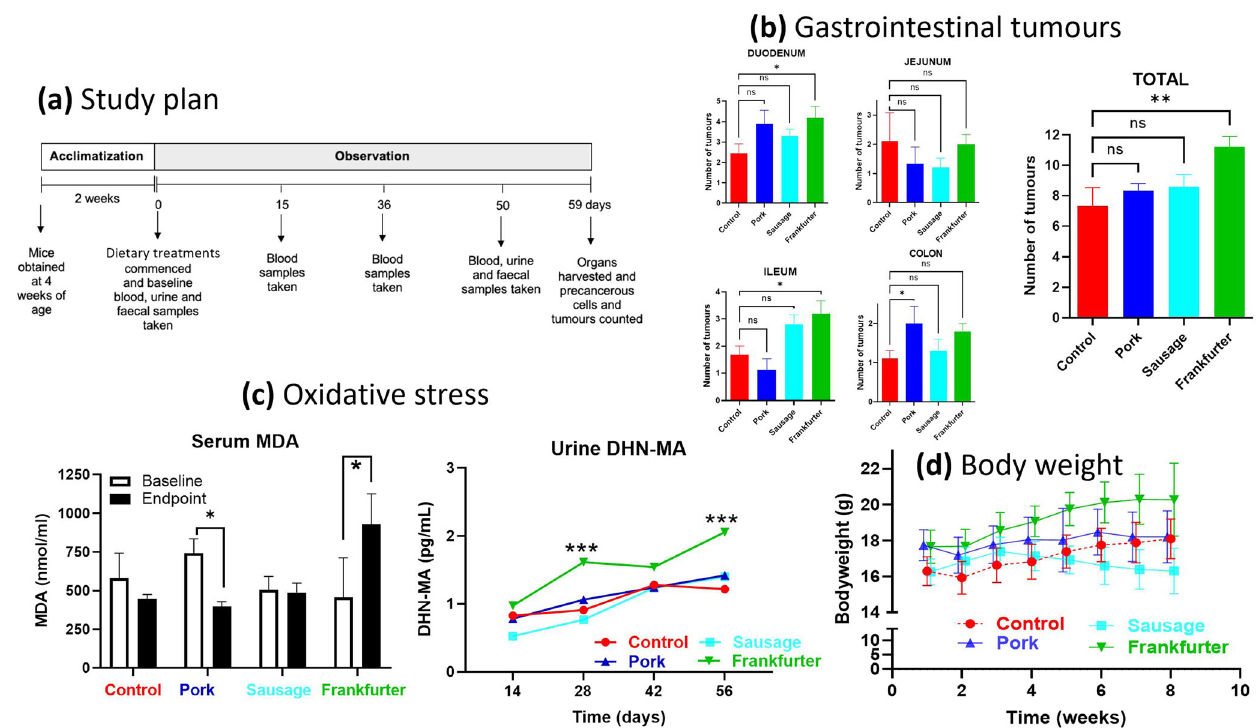
Fig. 1 APC Min mice consuming 15% frankfurter (85% chow) for 8 weeks have signi fi cantly more gastrointestinal tumours, higher levels of lipid peroxidation, and greater bodyweight than APC Min mice consuming a control diet (100% chow). a after acclimatisation mice were fed one of four chow diets which were either Control ( n = 9; standard chow (red)), or chow with a 15% incorporation of pork mince ( n = 9; blue), pork sausage ( n = 10; light blue), or nitrite-containing frankfurter sausage ( n = 10; green). b numbers of tumours did not differ between any groups in any of the speci fi c regions of the GI tract. However, compared with control signifcantly more tumours were displayed by the frankfurter group alone. c terminal serum MDA concentrations of mice consuming frankfurter were elevated compared to that of control terminal samples, after controlling for baseline using an ANCOVA. Urine DHN-MA concentrations were compared between groups at the same timepoint using an ANOVA. Levels in mice consuming frankfurter supplemented chow had higher levels at 28 and 56 days. d bodyweights of frankfurter-fed mice were consistently higher than control mice. Error bars shown represent s.e.m.